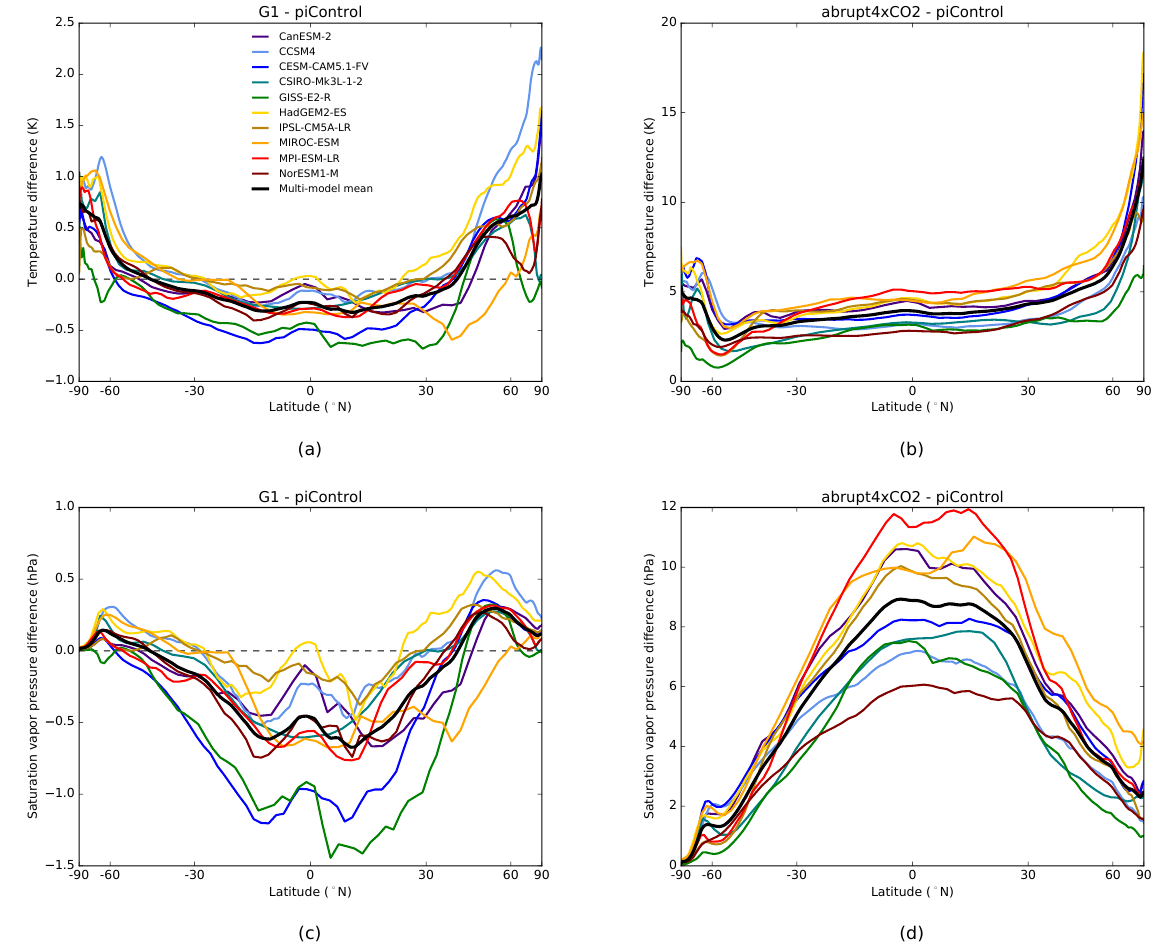
Figure 3. Zonal mean surface air temperature changes relative to piControl for G1 (a) and abrupt4xCO2 (b) , and analogous zonal mean surface saturation vapor pressure changes (c, d) , in GeoMIP models and the multi-model